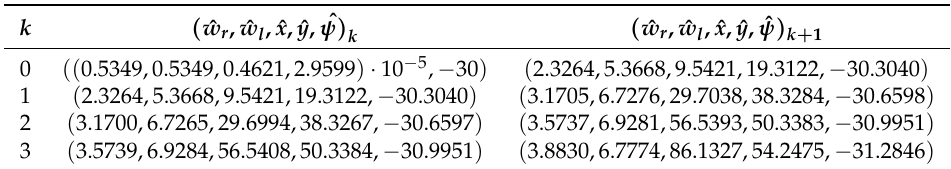
Table 1. Example for h = 1.